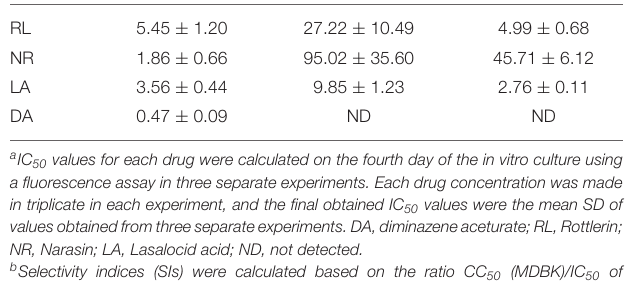
(RFUs) in treated groups reached 960, 1,200, 3,100, and 890 in 7 mg/kg of NR, 5 mg/kg of RL, 1 mg/kg of LA, and 20 mg/kg of